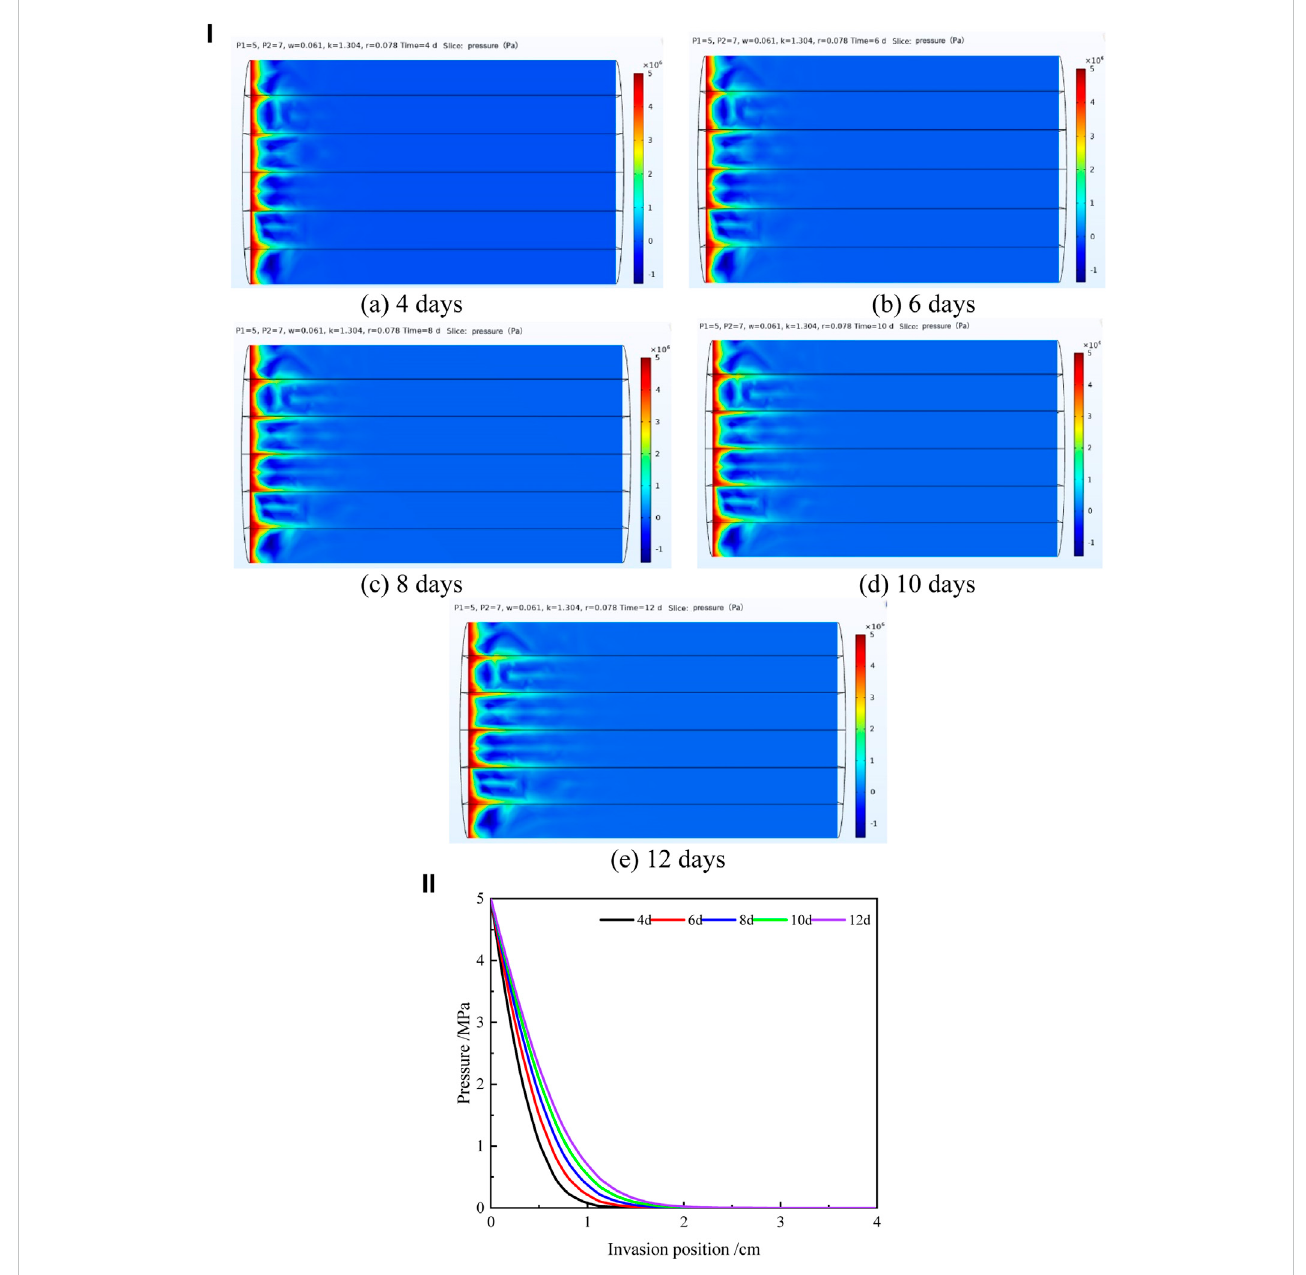
FIGURE 10 (i) : Cloud diagram ofthe invasion effect atdifferentinvasion times. (A) 4 days, (B) 6 days, (C) 8 days, (D) 10 days, and (E) 12 days. (ii) : Changes ofpressure between bedding fractures with the invasion position at different invasion times.